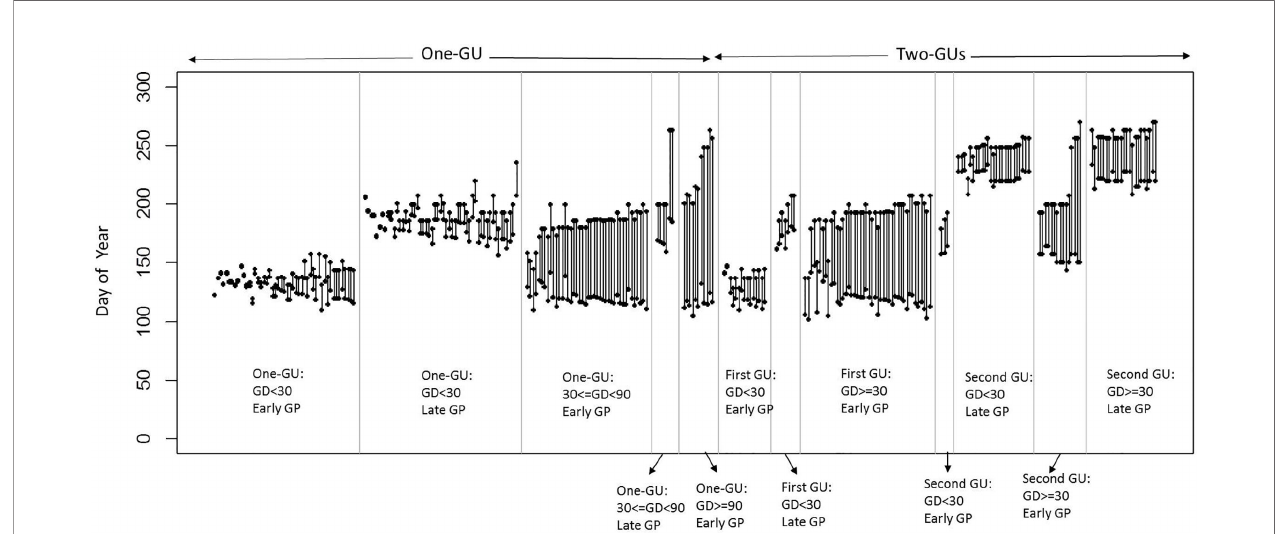
FIGURE 2 | Growth duration (GD) and growth period (GP) of the GUs for the different shoot categories (one-GU and two-GUs). The dots represent the start and cessation dates of growth for each GU. Two GPs (early and late) are de fi ned by a threshold of June 3, 2016, for one-GU and fi rst GUs of two-GUs, and July 18, 2016, for the second